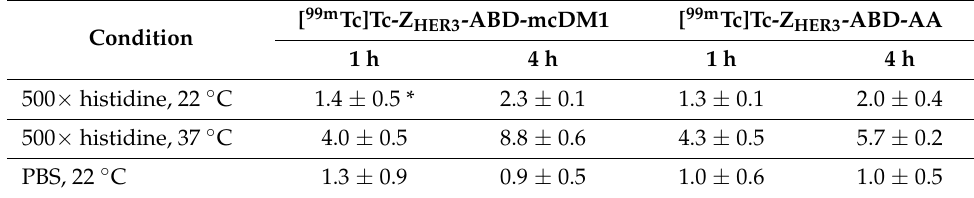
Table 2. Radiolabel stability of [ 99m Tc]Tc-Z HER3 -ABD-mcDM1 and [ 99m Tc]Tc-Z HER3 -ABD-AA.